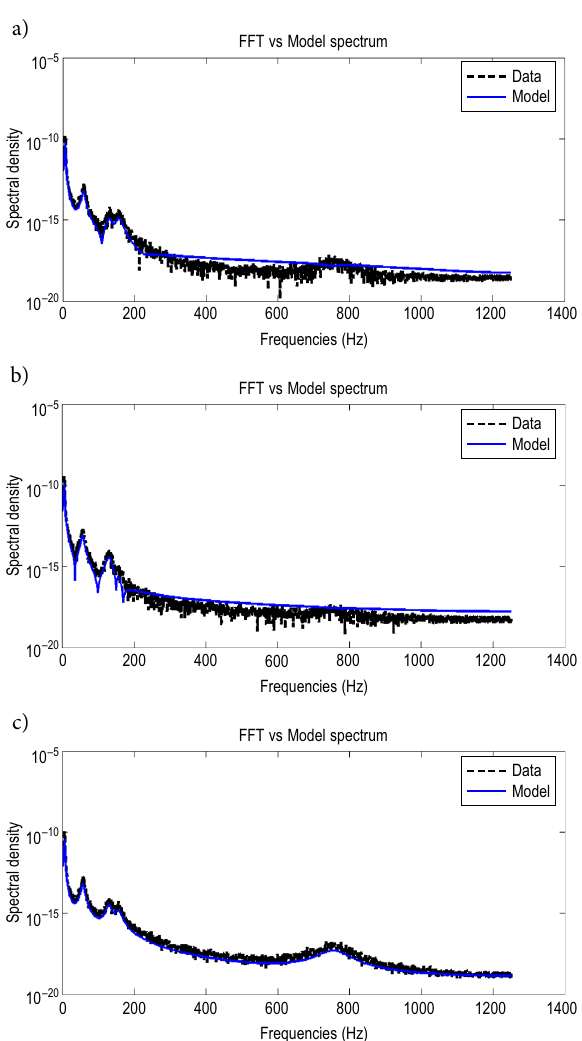
Fig. 5. Cross spectrum of the Tripod simplex structure (a) Auto spectrum sensor 3, (b) Cross spectrum between 3 and 4, (c) Cross spectrum between 3 and 7